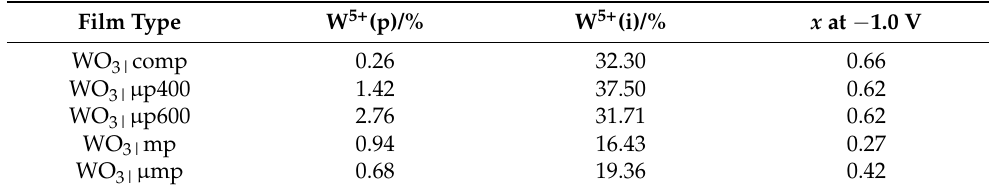
Table 4. Concentration of W 5+ in pristine (p) and intercalated (i) WO 3 thin films obtained from XPS and the degree of reduction for these experiments expressed as Li + content x in Li x WO 3